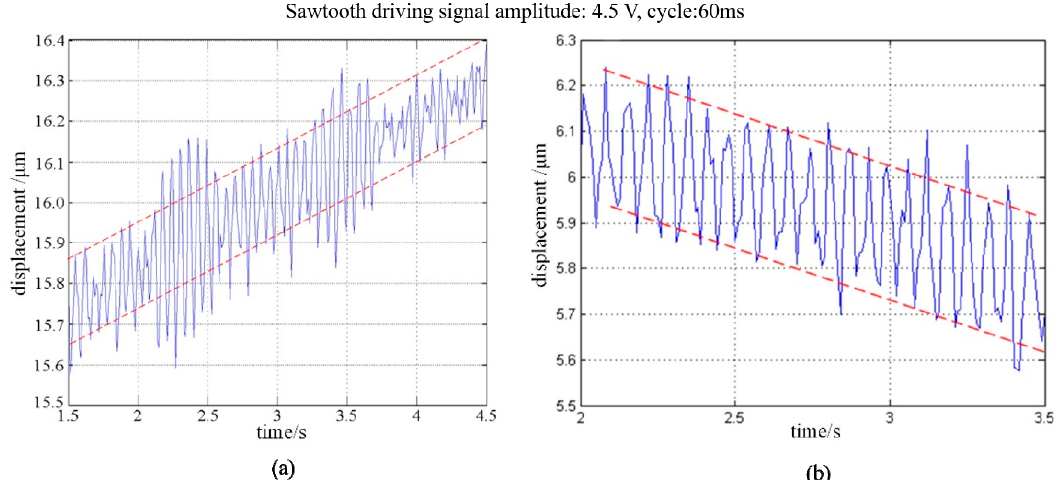
Figure 13. Forward and backward displacement of the stage under conventional sawtooth driving signal: ( a ) forward movement; ( b ) backward signal: ( a ) forward movement; ( b ) backward movement.